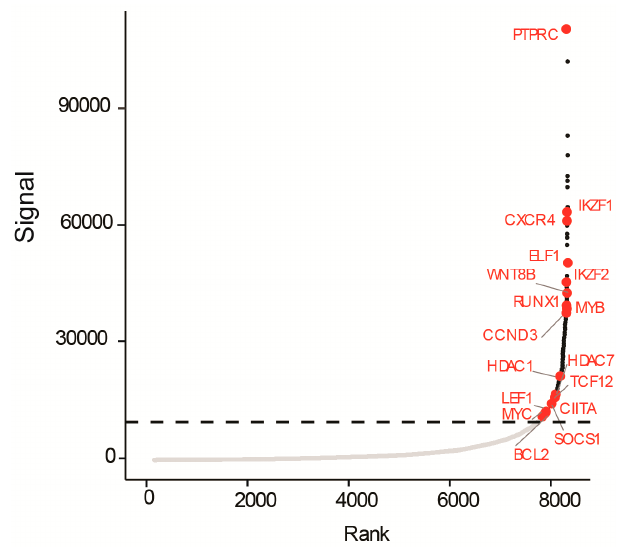
Figure 4. Histone H3 lysine 27 acetylation (H3K27ac) chromatin immunoprecipitation (ChIP) sequencing identifies putative super-enhancers in UP-ALL13 cells. Hockey-stick plot representing the normalized rank and signal of H3K27ac peaks in t(8;14)(q24;q11)-positive UP-ALL13 cells. Representative super-enhancer-associated genes are shown in red.